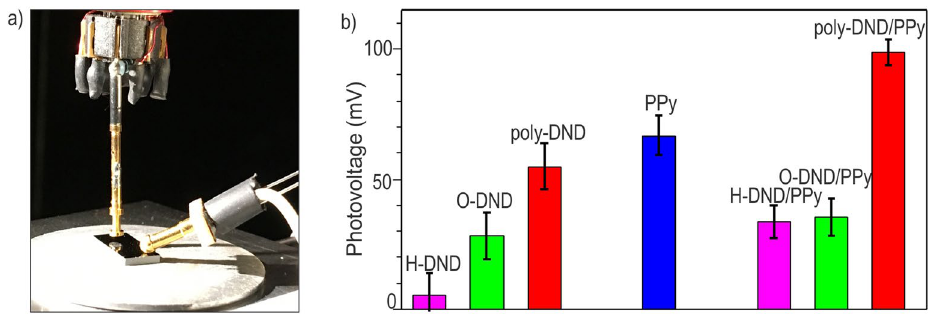
Figure 6. ( a ) Scanning Kelvin probe setup. ( b ) Surface photovoltages (with error bars) of DND/PPy composites, DND and PPy